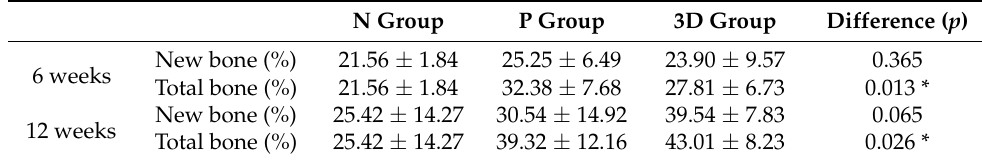
Figure 3. Histological evaluation using hematoxylin and eosin (H & E) staining and Goldner’s trichrome (GT) staining (N group = negative group without graft, P group = positive group grafted with Bio-Oss, 3D group = study group grafted with 3D-printed ceramic block; yellow asterisk: grafted bone substitutes; black arrowhead: osteoblast): ( a ) 6 weeks; ( b ) 12 weeks. Table 2. Histological analysis of new bone formation in each group at 6 and 12 weeks.